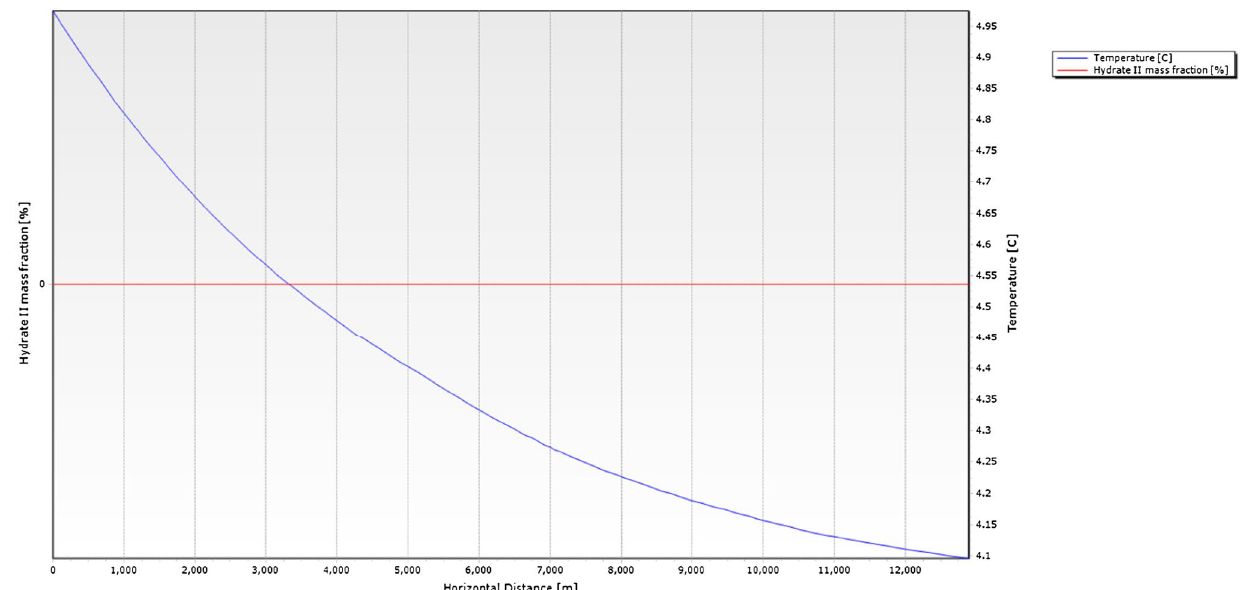
Fig. 12 Pipeline profile after MEG